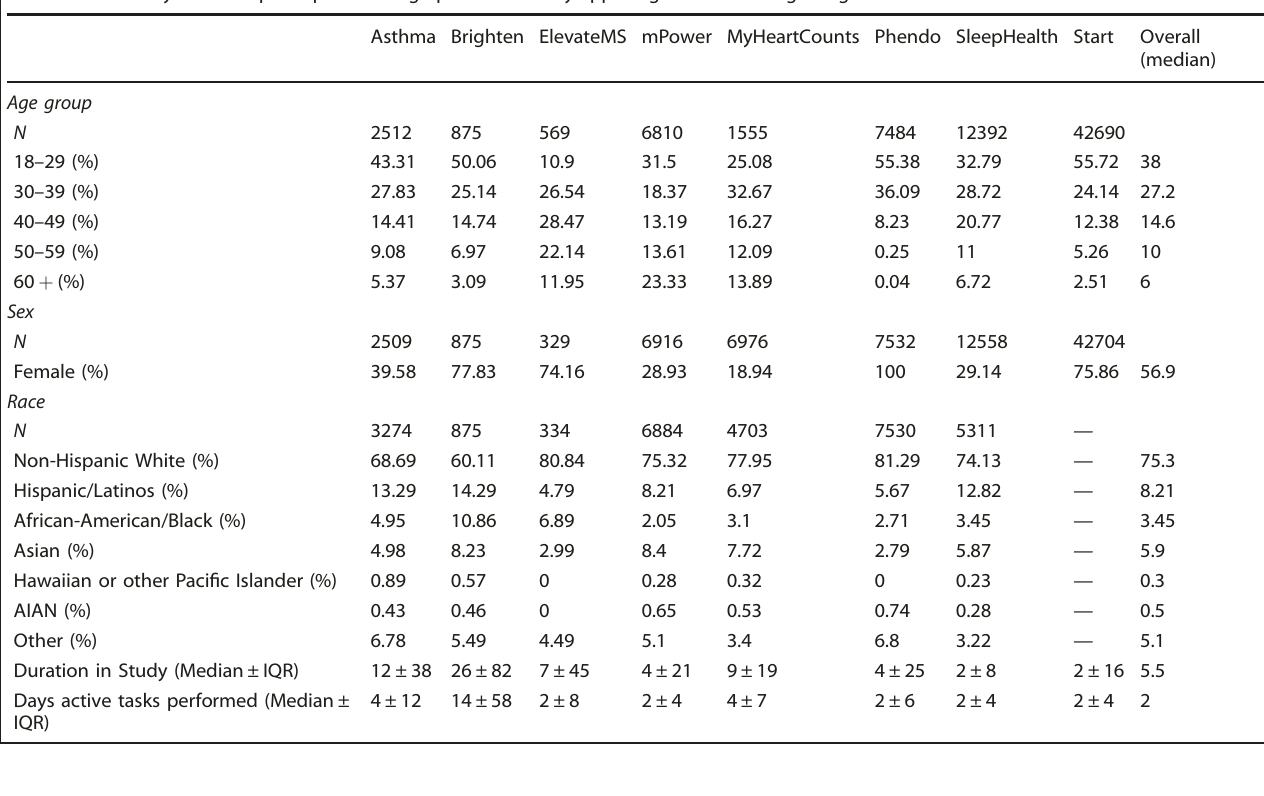
Table 2. Summary of select participant demographics and study-app usage across the eight digital health studies.